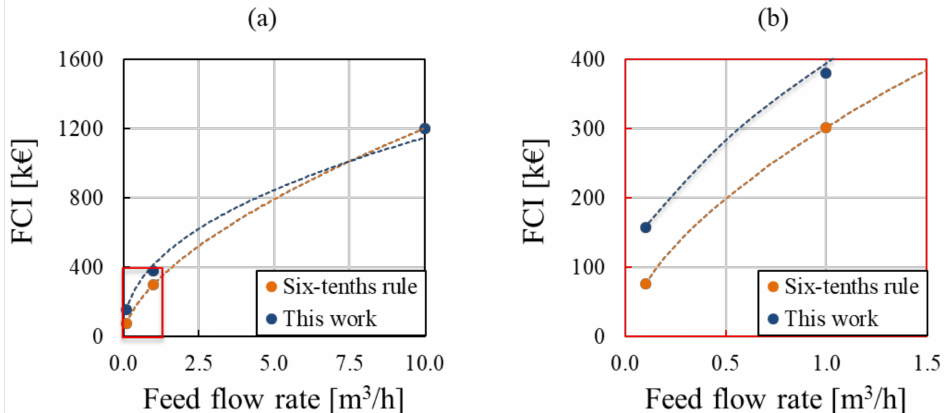
Figure 2. Trend of Fixed Capital Investment versus feed flow rate (plant capacity) obtained in the present work (blue curve) and by the six-tenths rule (orange curve) for a capacity ranging between ( a ) 0.1–10 m 3 /h and ( b ) 0.1–1.5 m 3 /h (in fact, ( b ) is a zoom of ( a )).